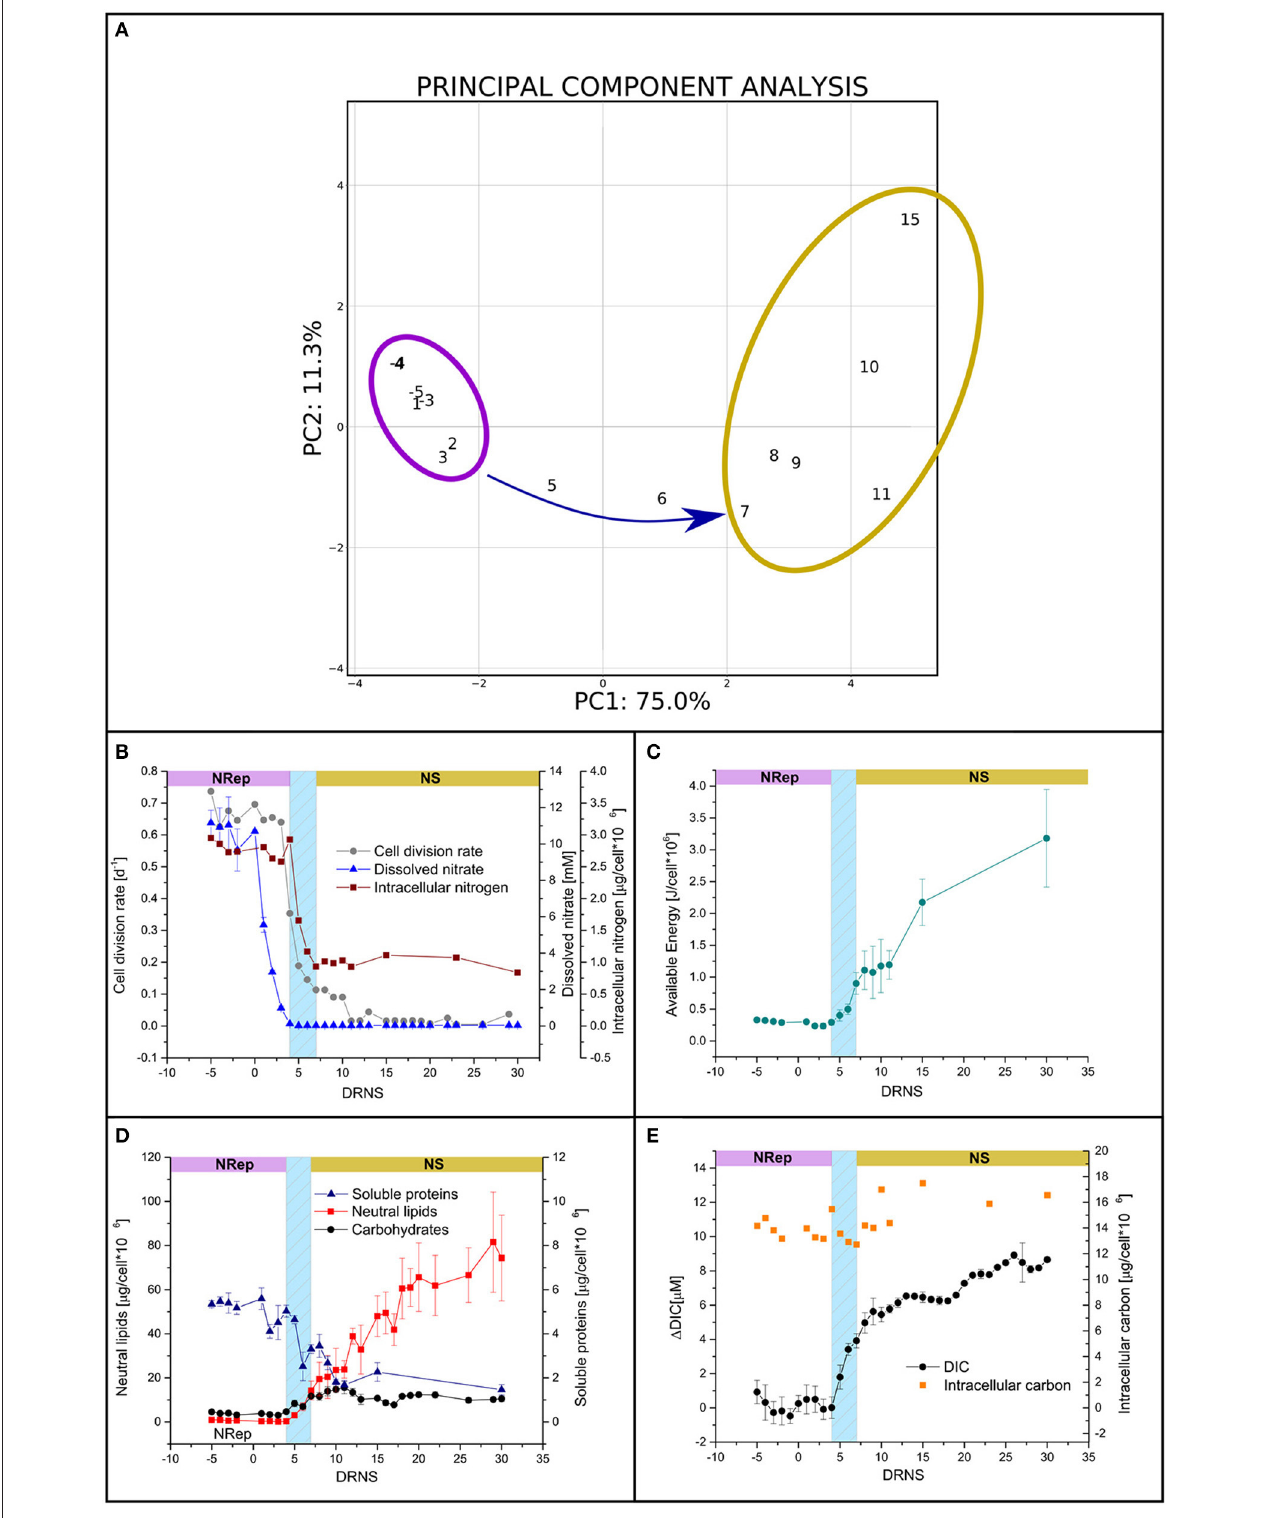
FIGURE 1 | Culture parameters in response to the transition from nitrogen-repleted (NRep) to nitrogen starvation (NS) conditions. (A) Principal component analysis (PCA) of the different physiological and biochemical traits. The first two components of the PCA explain 86,3% of the variance, 75% is explained by the first component allowing the outline of two groups: the NRep (Violet) and NS (Yellow) groups and the transition links them together. (B) Time-courses of cell density (grey circles), N-int (Red squares), and N-ext (blue triangles). (C) Cellular available biochemical energy during the time course of the experiment. Day 0 refers to DNRS. (D) Soluble proteins (blue triangles), carbohydrates (black circles), and neutral lipids (red squares) cellular quota. (E) DIC and intracellular carbon. Frontiers in Plant Science |